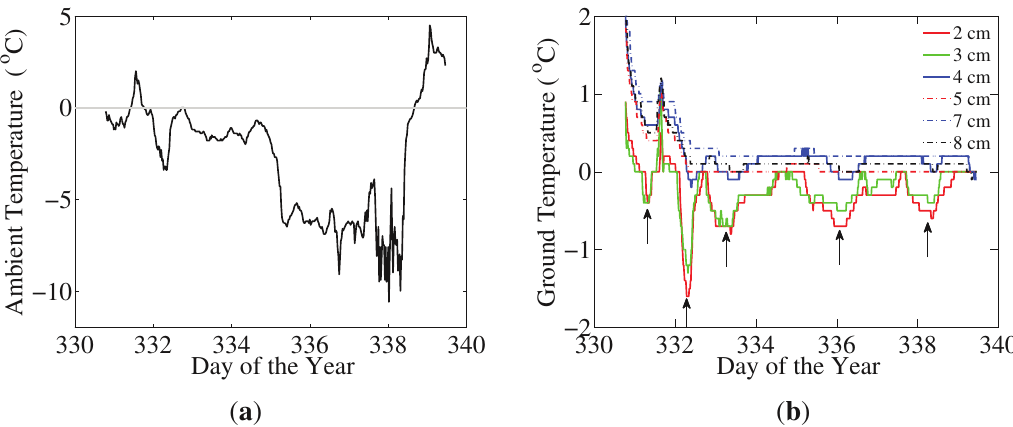
Figure 3. ( a ) Time series of air temperature and ( b ) soil temperature recorded at shallow depths (2, 3, 4, 5, 7, 8 cm) over a nine-day period. Arrows indicate the freeze-thaw cycles as the soil temperature dynamics is below 0 ◦